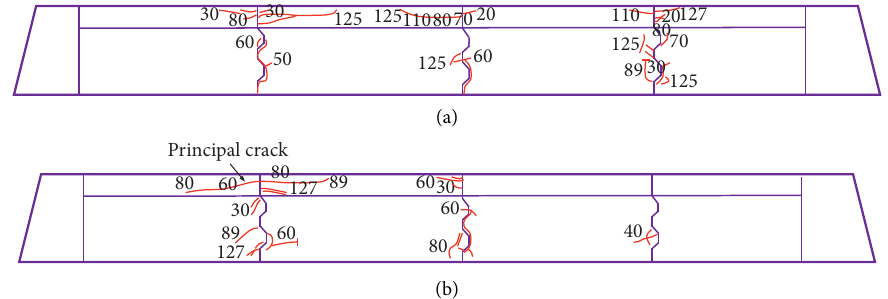
Figure 11: Crack distributions of specimen 5: (a) front profile; (b) back profile.